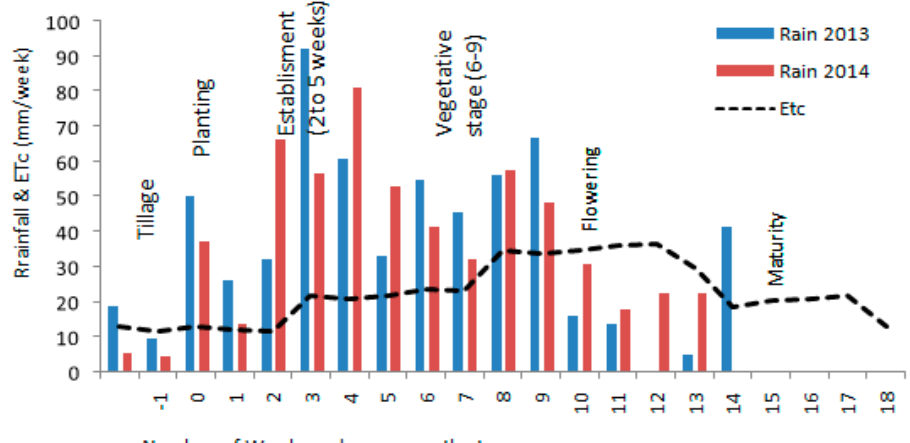
Figure 4. Weekly rainfall amount with crop evapotranspiration (ETc) for maize at the experimental site during the 2013 and 2014 cropping seasons.